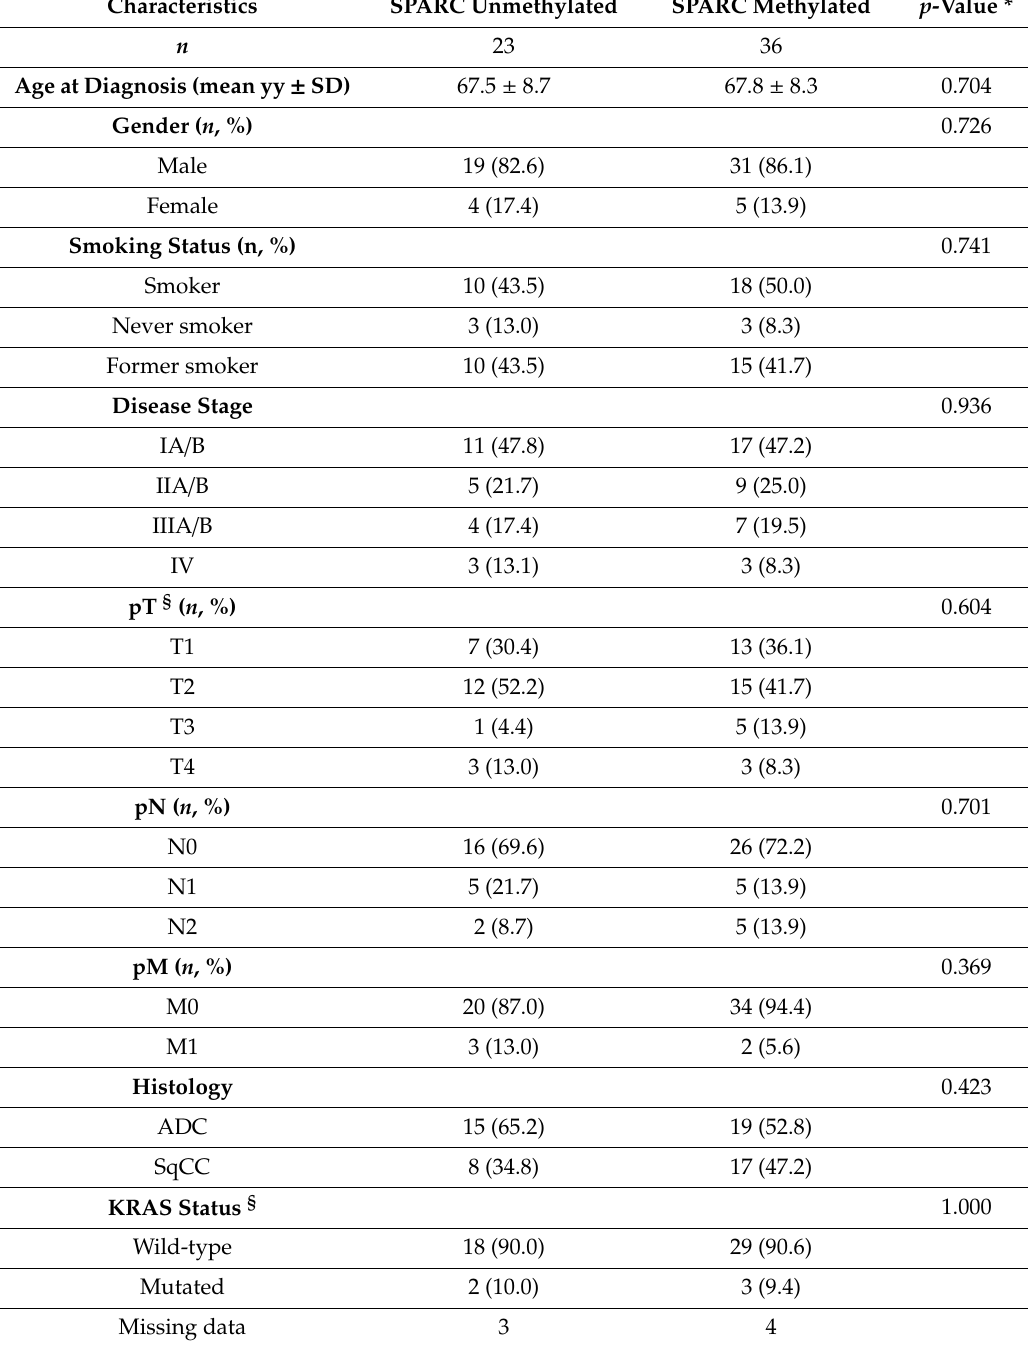
Table 2. Patients’ characteristics according to SPARC methylation status (methylated /